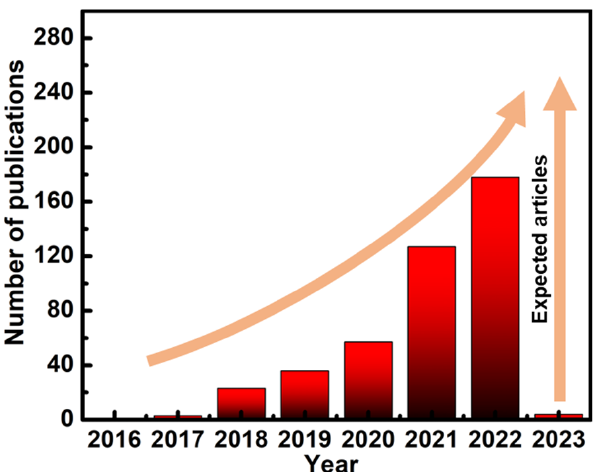
Figure 1. Growing importance of MXene-based porous monoliths in increasing number of SCI indexed publications (source: SciFinder 2022).